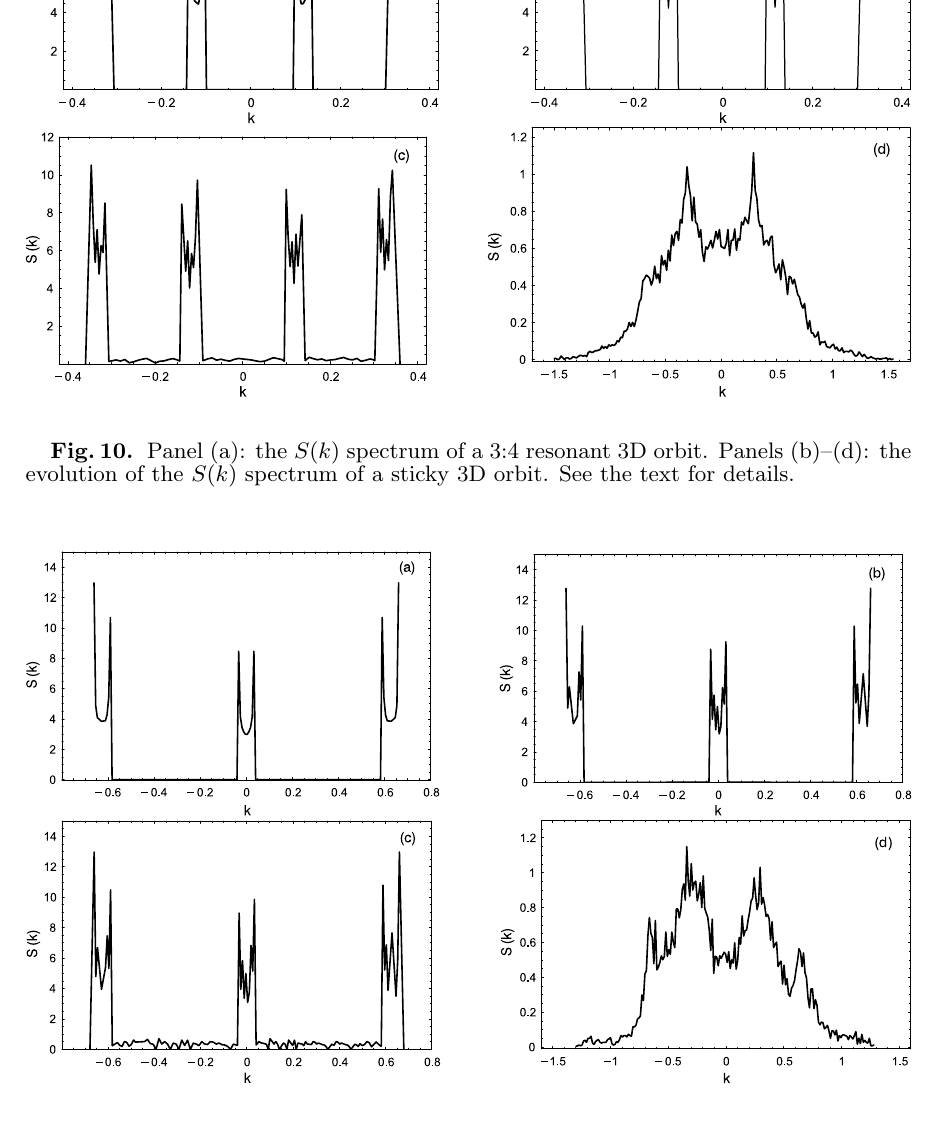
Fig. 11. Panel (a): the S ( k ) spectrum of a 2:3 resonant 3D orbit. Panels (b)–(d): the evolution of the S ( k ) spectrum of a sticky 3D orbit. See the text for